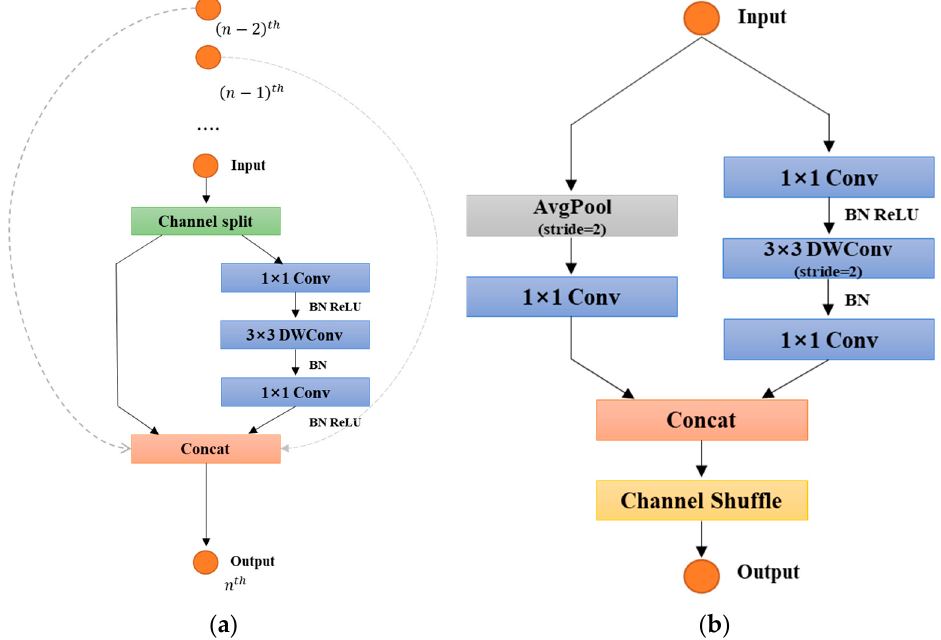
Figure 5. Architecture of EffShuff-Dense block and EffShuff-Dense transition. The main difference between EffShuff block and EffShuff-Dense block is that the Concat layer retrieves dense connection from previous layers. ( a ) EffShuff-Dense block; ( b ) EffShuff-Dense transition.